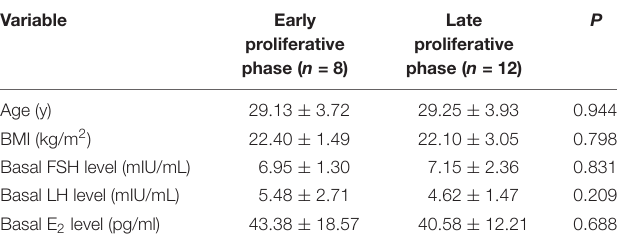
TABLE 2 | Demographic characteristics of the women in proliferative phase recruited in this study.